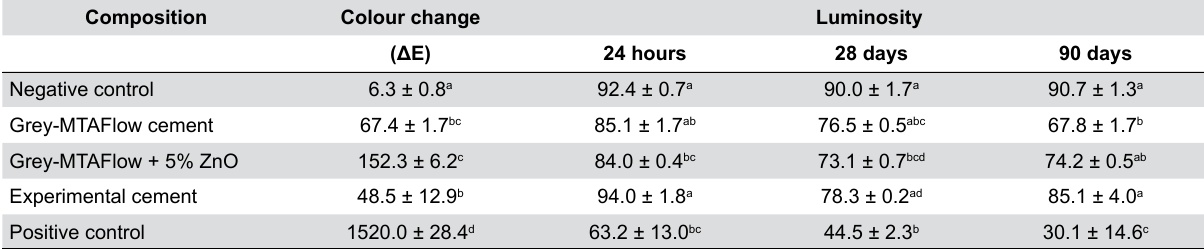
Table 1- Mean and standard deviation values of color change (ΔE) after 90 days, and luminosity (L) at 24 hours, 28, and 90 days of analysis. Different lowercase letters in each column indicate statistically significant